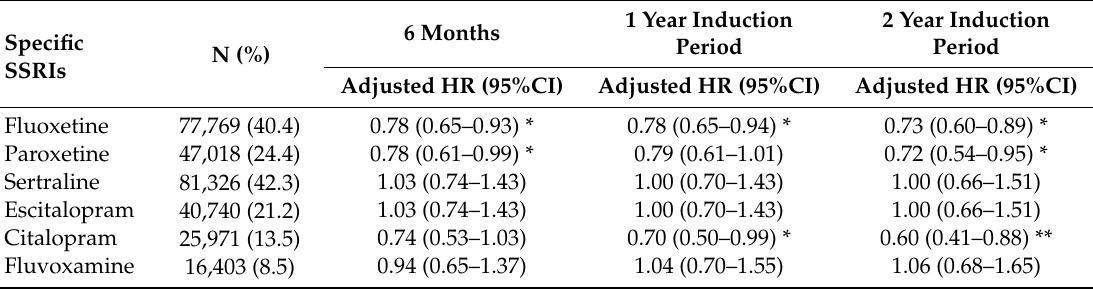
Table 3. Association of SSRI use and the risk of bladder